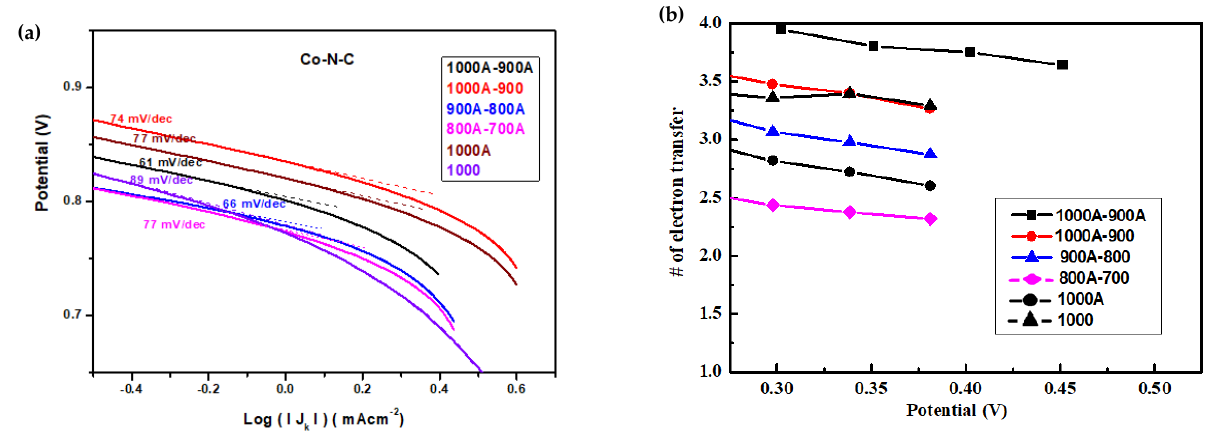
Figure 9. ( a ) Tafel plot derived from LSV curves and ( b ) number of electrons transferred during ORR for various Co-N-C catalysts. Table 3. Comparison of various electrochemical properties of all Co-N-C catalysts.